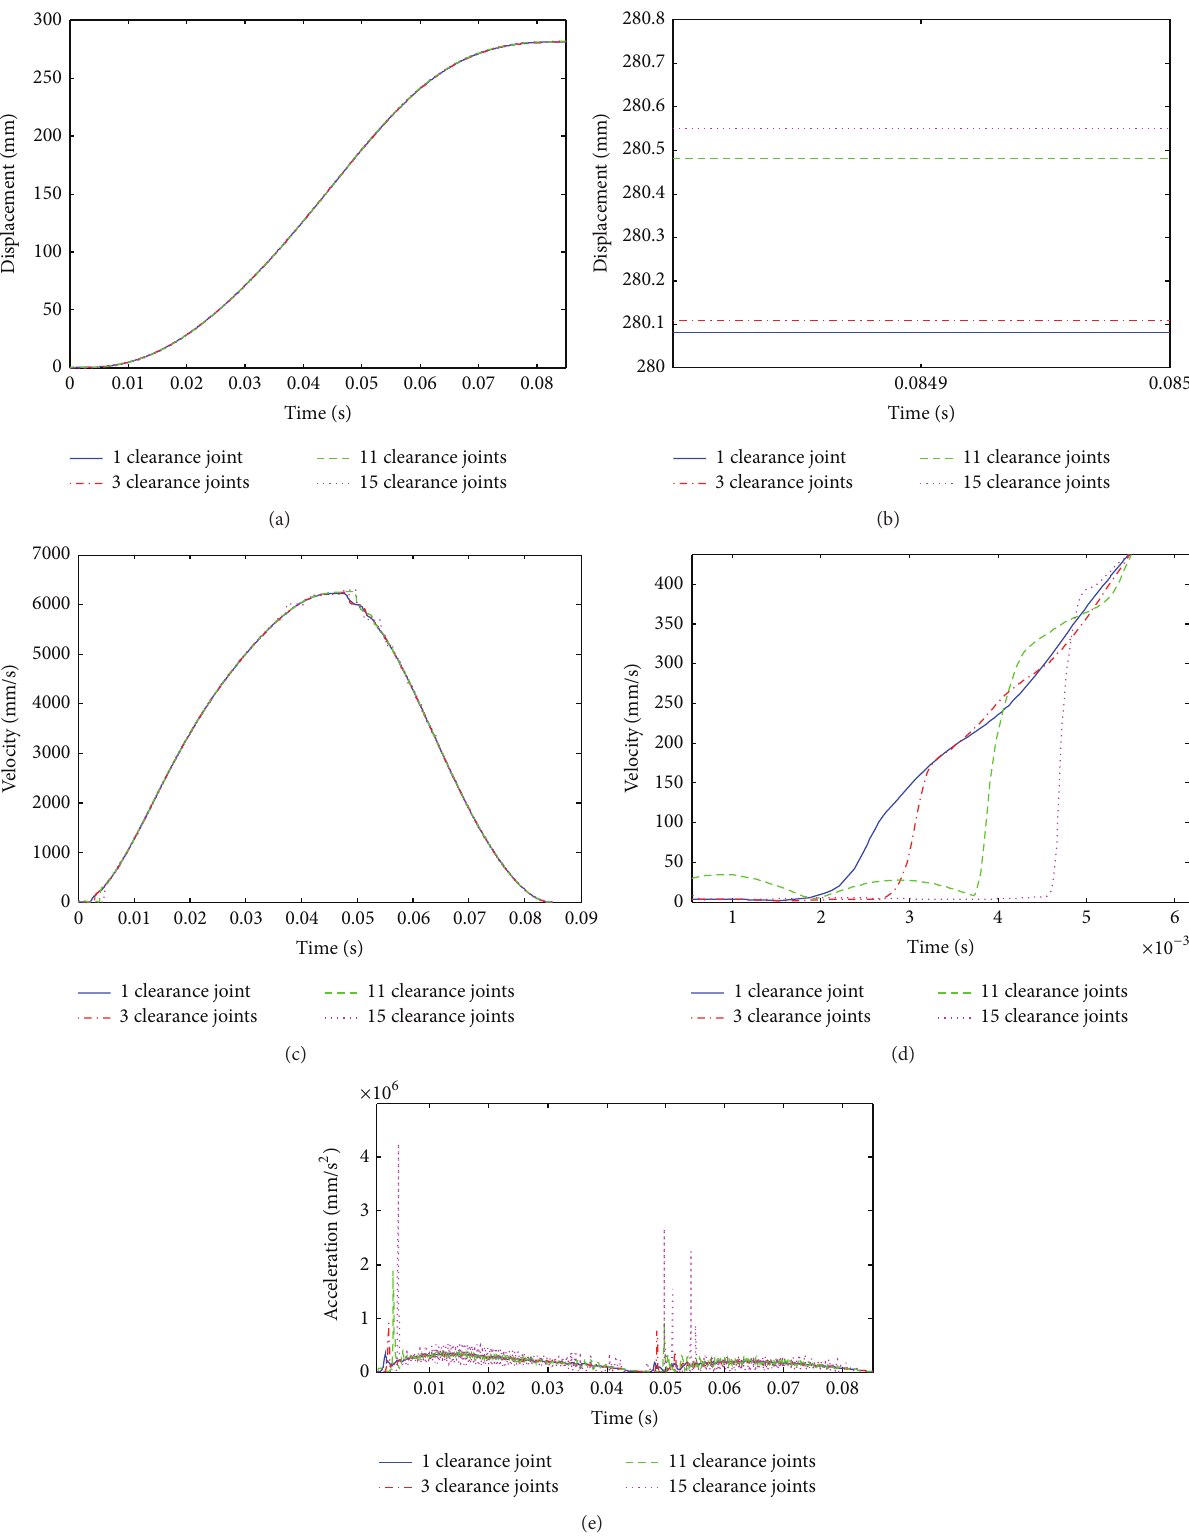
Figure 18: Responses for different number of clearance joints: (a) displacement, (b) enlarged drawing of displacement, (c) velocity, (d) enlarged drawing of velocity, and (e)